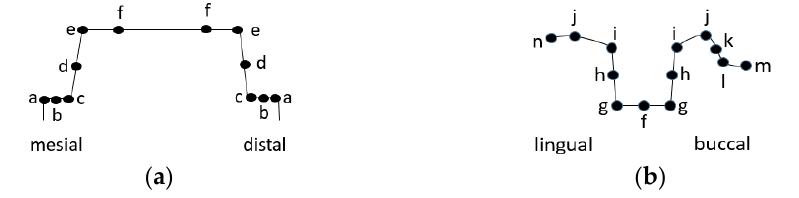
Figure 3. Schematic presentation of measurement location ( a ) in mesio-distal section and ( b ) bucco- lingual section; marginal points = a, m, and n; internal points = b, c, d, e, f, g, h, i, j, k, and l.